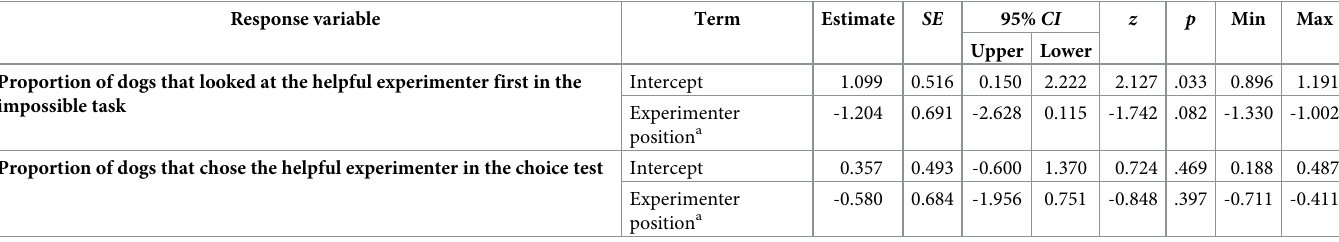
Table 2). We also conducted a GLM to test whether dogs chose the helpful person in the choice test, which revealed no significant difference in the proportion of choices for the helpful exper- imenter when the experimenters stayed on the same side or swapped positions ( p = .397) (Fig 5, Table 2).